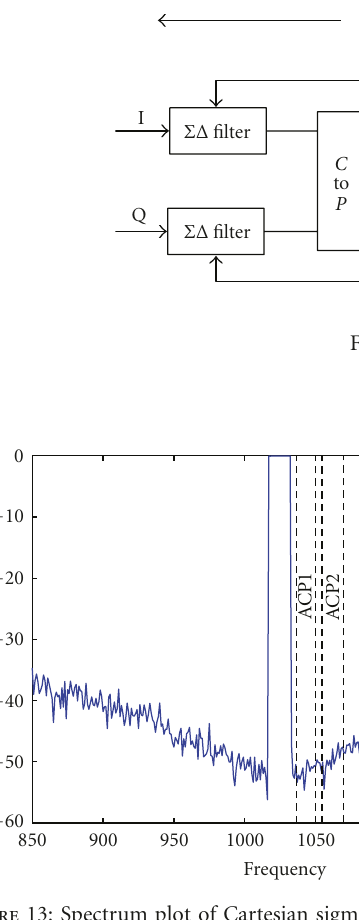
Figure 13: Spectrum plot of Cartesian sigma delta, n = 16, f c = 1024 MHz, OFDM channel bandwidth = 20MHz.